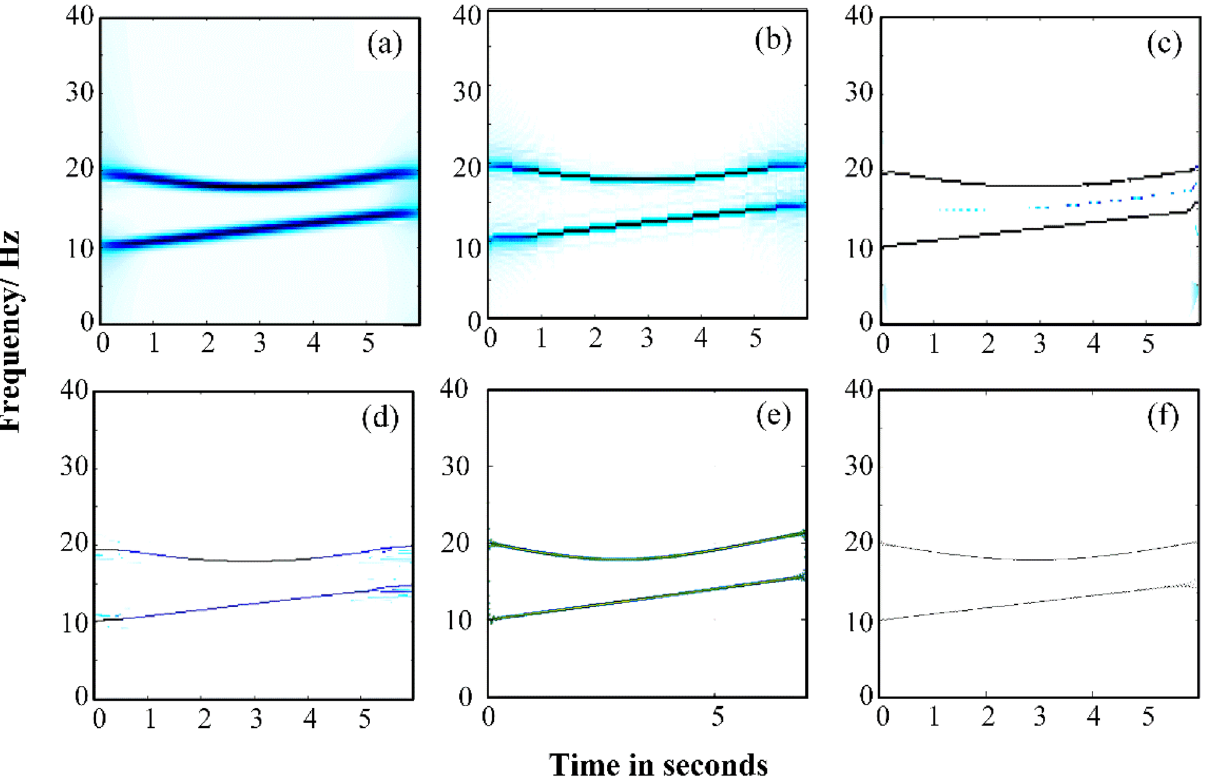
Figure 6. The TFR result calculated using ( a ) STFT, ( b ) GWT, ( c ) SET, ( d ) SSET ( e ) Fourier–Bessel series expansion based empirical wavelet transform ( f )